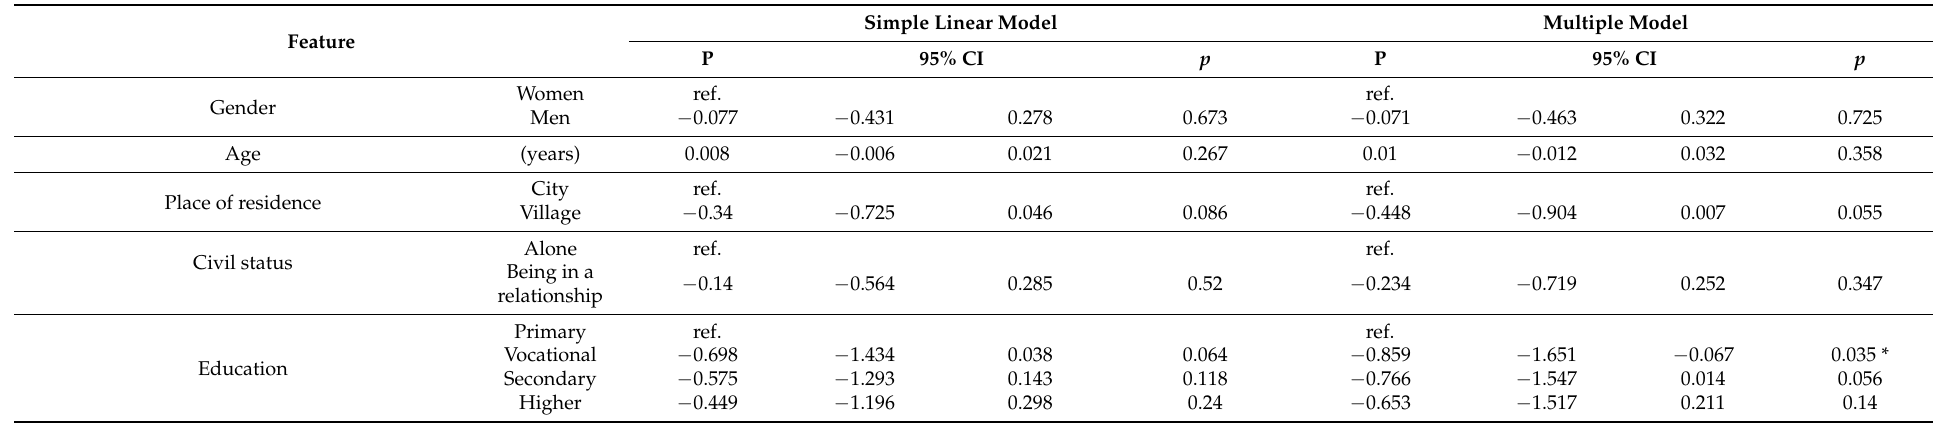
Table 5. ARMS taking medications and refilling prescriptions: simple linear regression and multiple regression